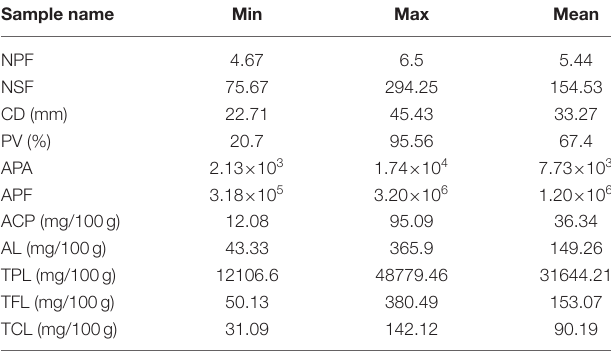
TABLE 2 | Statistical analysis of the 11 flower and leaf related traits.